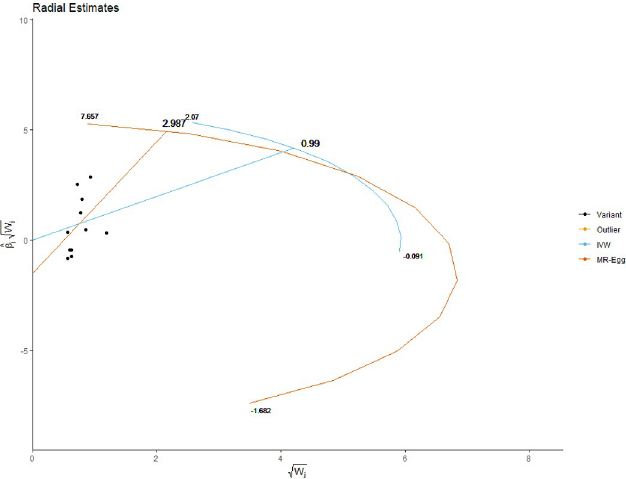
Fig 17. Radial plot of weight as the exposure. No significant outliers were